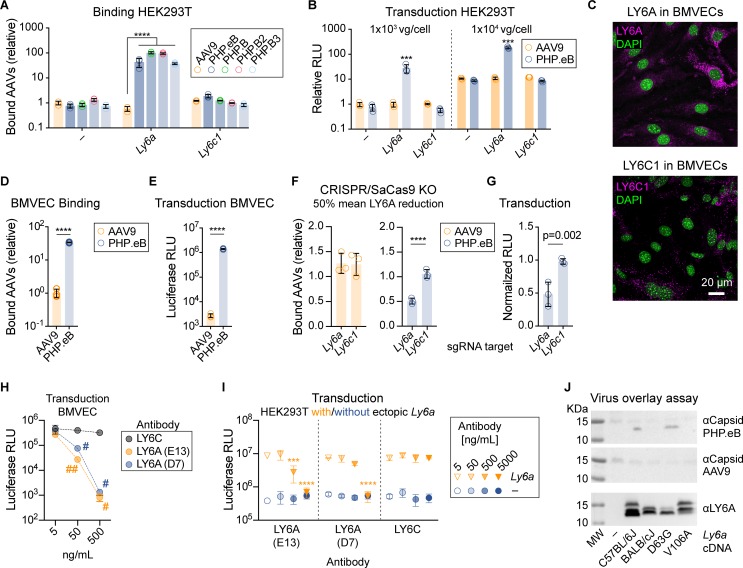
Ly6a mediates enhanced binding and transduction by AAV-PHP.eB.(A) Binding of the indicated virus to HEK293T cells transfected with Ly6a or Ly6c1 or left untransfected (–). (B) Transduction measured by Luciferase assay normalized to AAV9 on mock transfected cells. (A, n = 3/group, ****p<0.0001; 2-way ANOVA, Tukey’s correction; B n = 3/group, ***p<0.001; 3-way ANOVA). (C) LY6A (magenta, top) and LY6C1 (magenta, bottom) immunostaining with nuclei (green, DAPI) in BMVECs. AAV9 and AAV-PHP.eB binding (D) and transduction (E) of BMVECs (n = 3/virus, mean ± S.D., ***p<0.0001; two-tailed t test). Binding was assessed by qPCR of the viral genome. Transduction was assessed by measuring Luciferase luminescence in relative light units (RLU). Binding (F; 2-way ANOVA, Dunnett’s multiple comparison test) and transduction (G; 1-way ANOVA, Sidak’s post test) by the indicated virus in cells treated with a vector containing an sgRNA to disrupt Ly6a or Ly6c1 or no sgRNA (n = 3/group, mean ± S.D., ****p<0.0001). Data in F and G are normalized to cells treated with a control vector lacking a sgRNA sequence. Each data point represents cells that received a different sgRNA. (H-I) AAV-PHP.eB-mediated transduction (Luciferase RLU) of BMVECs (H) or HEK293 cells mock transfected (-) or transfected with Ly6a (I) following the pre-incubation of cells with the indicated antibody (n = 2/group, H; or n = 3/group, I, #p = 0.023, ##p = 0.010, ***p = 0.001, ****p<0.0001, αLY6C vs. αLY6A, 2-way ANOVA, Tukey’s correction for multiple comparisons). (J) Virus overlay assay using lysates from HEK293T cells transfected with Ly6a cDNAs from C57BL/6J or containing one or both BALB/cJ SNPs. Panels show immunoblotting for AAV capsid proteins after overlaying with AAV-PHP.eB or AAV9. Bottom panel shows the αLY6A signal from the same blot previously overlaid with AAV-PHP.eB.